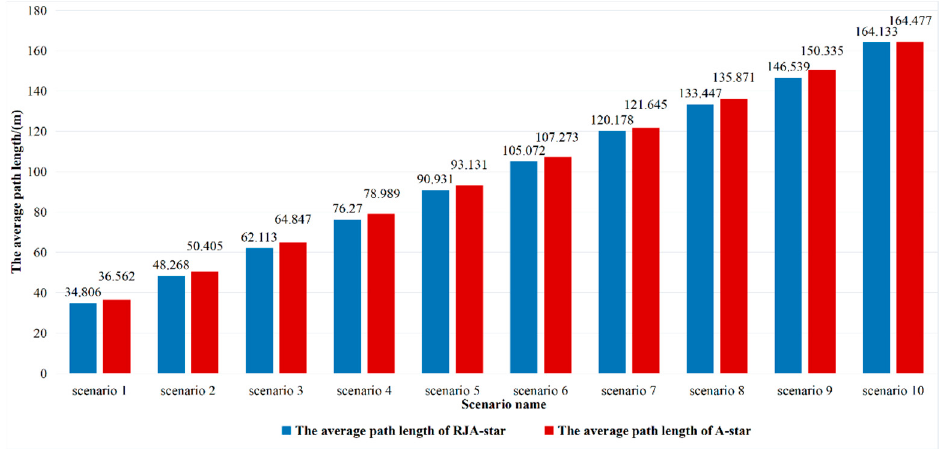
Figure 8. Comparison of path length between the two algorithms.